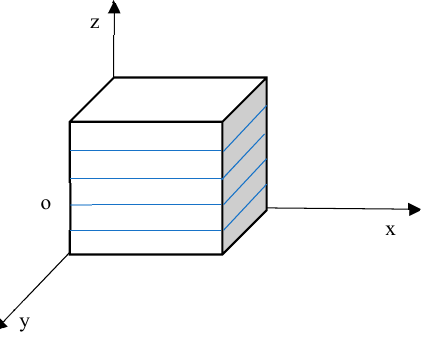
Figure 1. Transversely isotropic constitutive model.